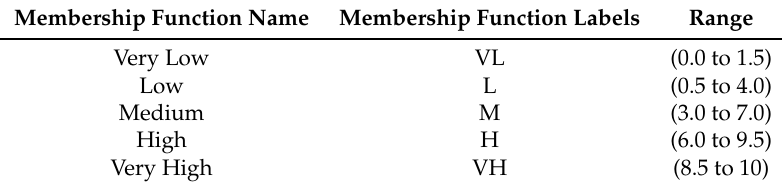
Table 4. Labels, ranges of input and output membership